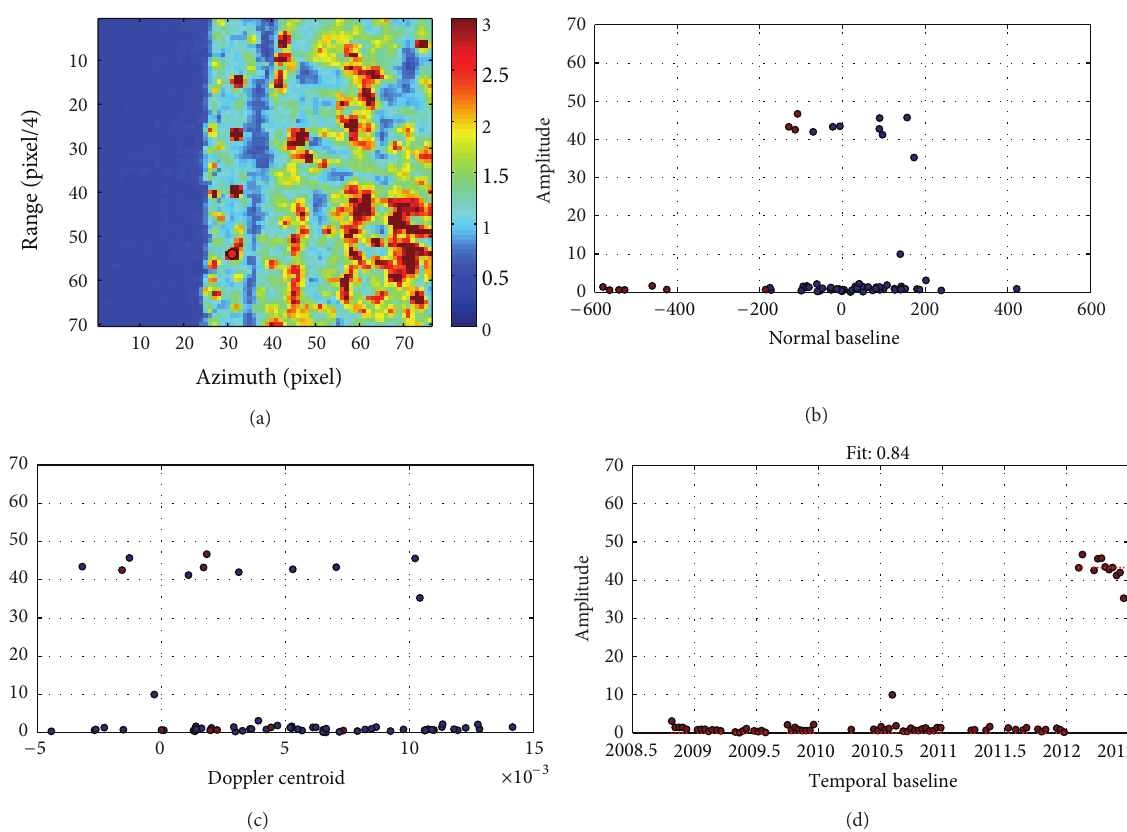
Figure 8: Amplitude analysis of the smaller corner reflector. (a) shows the location of the reflector; (d) shows the amplitude time series of the location. The amplitude leap indicates the deployment of reflectors.